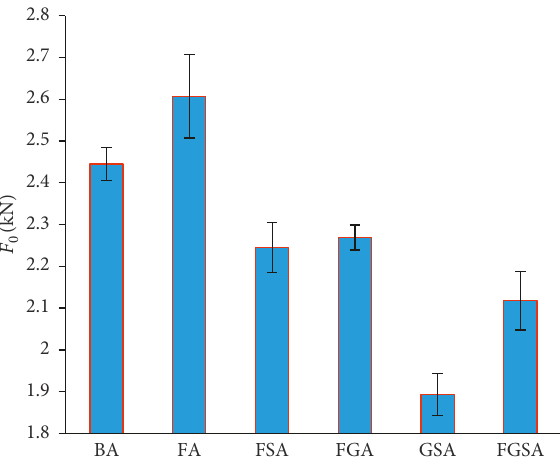
Figure 12: Fracture resistance of different asphalt concretes.